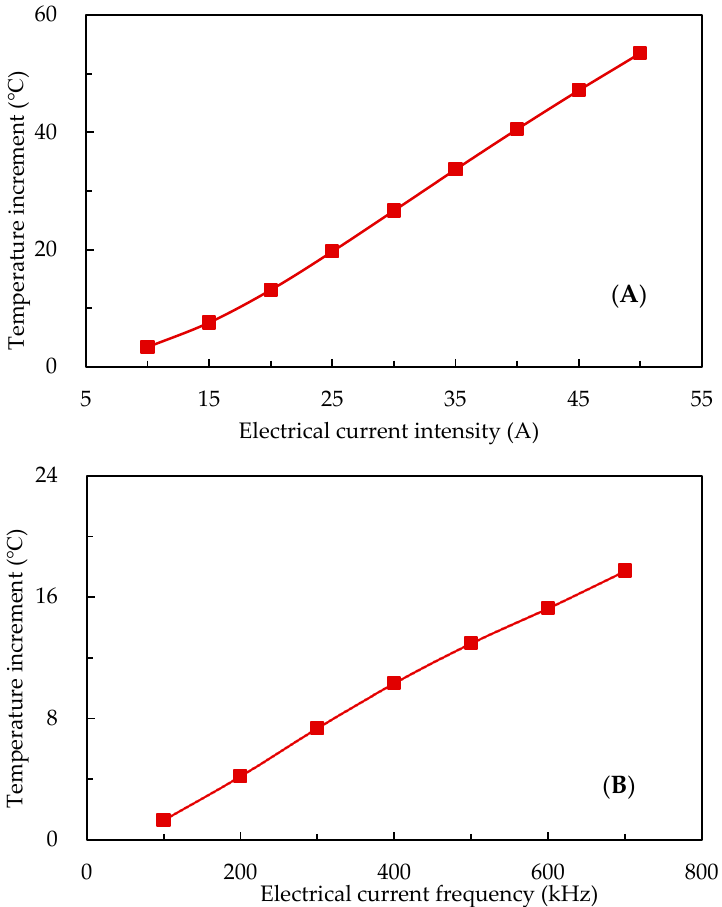
Figure 8. Effects of electrical current intensity and frequency on wax layer temperature increment ( A ) electrical current intensity (original wax layer temperature is 20 °C, magnetic field frequency is 500 kHz, SPM-NP diameter is 18 nm, pig velocity is 0.4 m/s, the flow rate is 0.4 m/s, induction coil turn number is 310 turns, and nanoparticle content is 10%) and ( B ) electrical current frequency (original wax layer temperature is 20 °C, electrical current intensity is 20 A, SPM-NP diameter is 18 nm, pig velocity is 0.4 m/s, the flow rate is 0.4 m/s, induction coil turn number is 310 turns, and nanoparticle content is 10%).